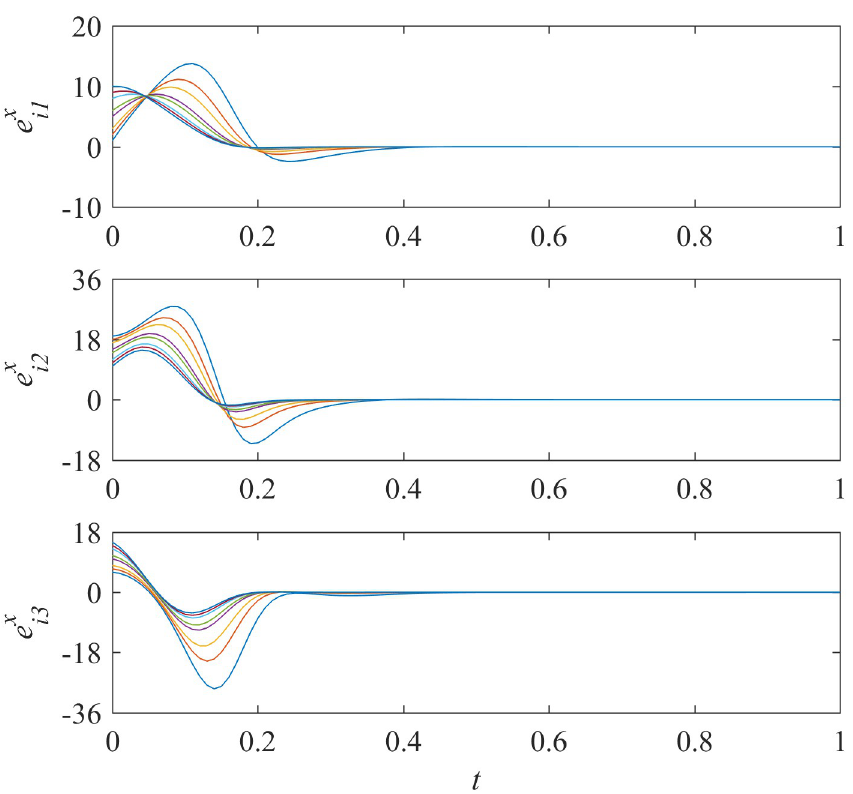
Fig 9. States of error system between the remaining nodes and the isolate node in sub-network X while node 4 and 7 are chosen to be out of work.